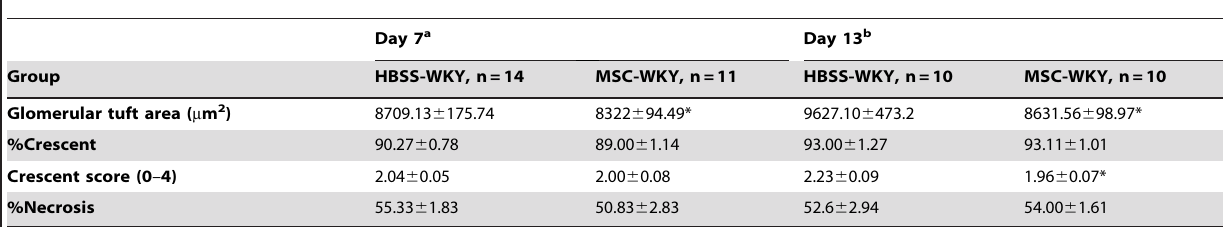
Table 1. Assessment of histological findings.